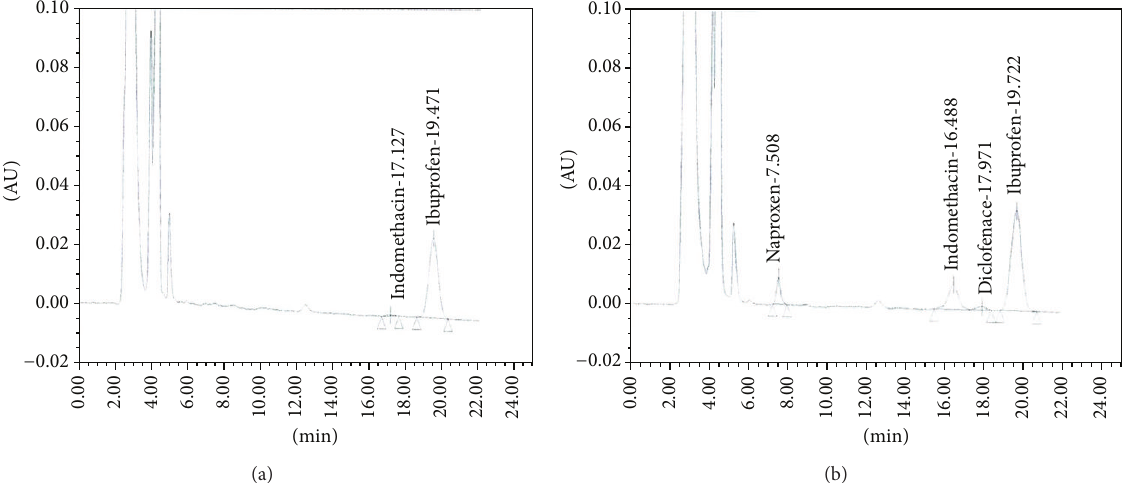
Figure 4: Chromatograms for nonsteroidal anti-inflammatory drugs (a) in a patient urine sample and (b) in a spike patient urine sample at 100 𝜇 gL −1 .